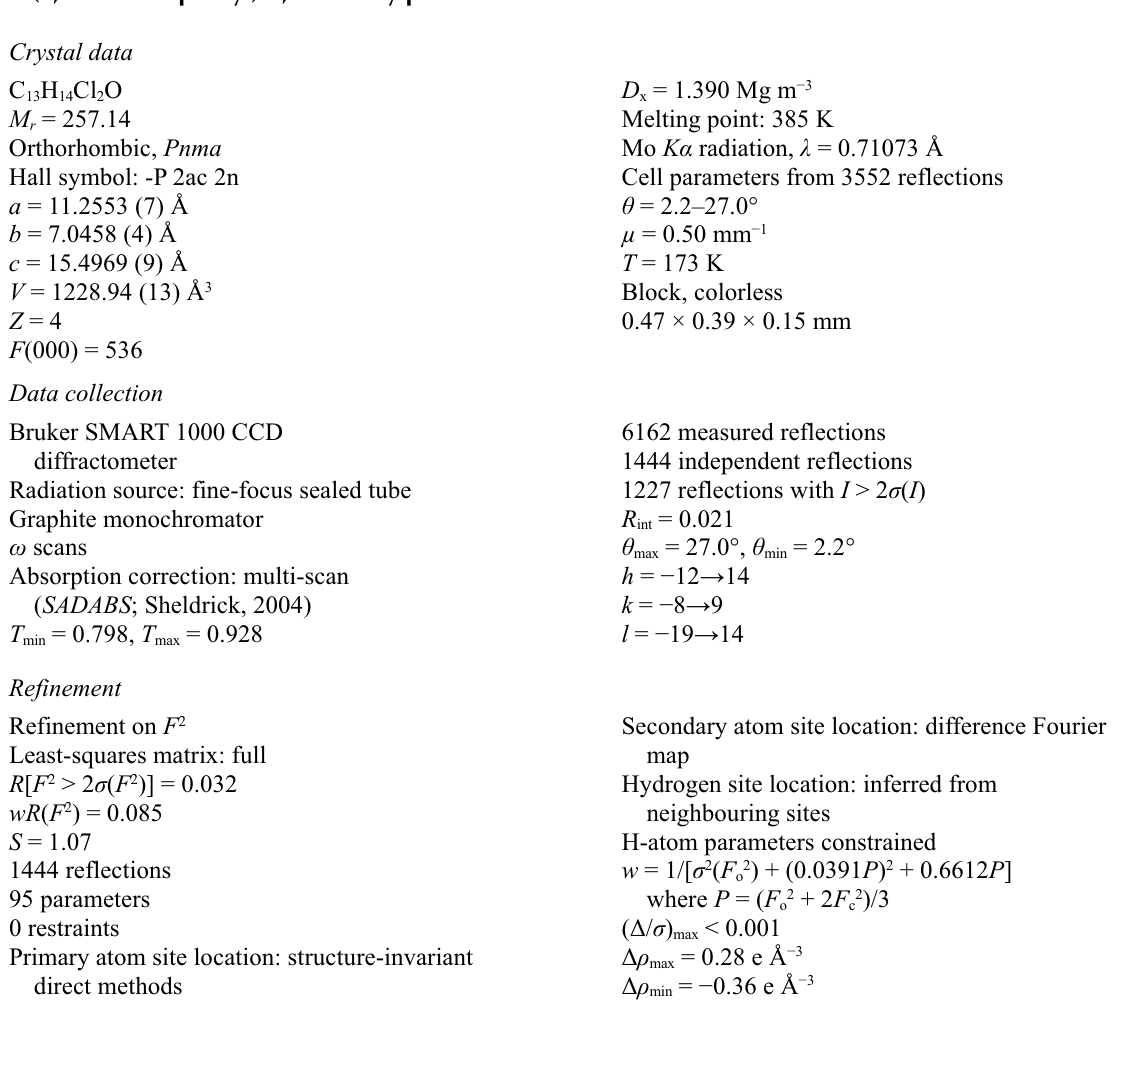
Figure 2 Packing diagram showing π – π stacking interactions.